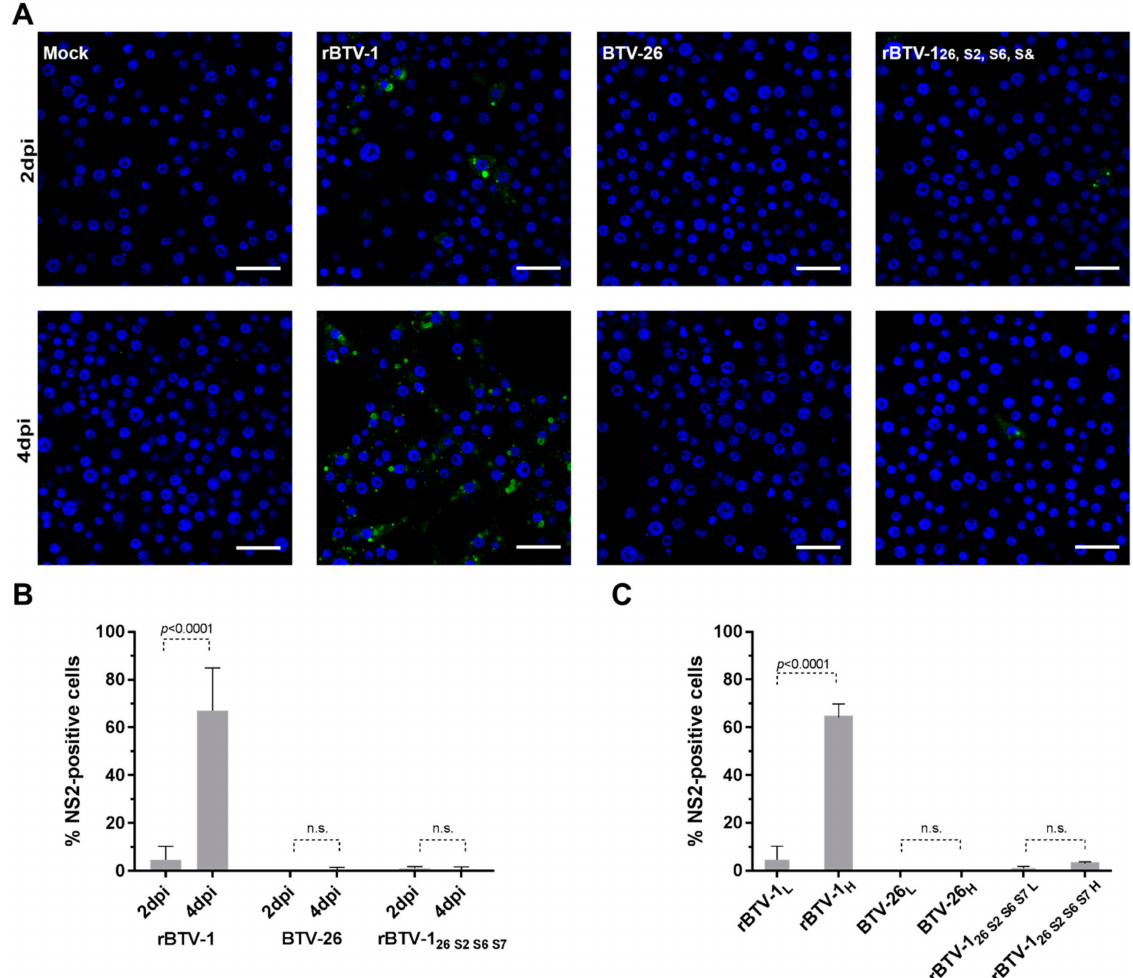
Figure 5. Intracellular replication of rBTV-1, BTV-26 and rBTV-1 26 S2,S6,S7 in Culicoides cells. KC cells were seeded at a density of 7.00E+05 cells/well on coverslips in a 24-well plate at a low MOI of 0.01 ( A , B ). At 2 or 4 days pi cells were fixed with 4% PFA and labelled for DNA (DAPI, in blue) and viral NS2 (Orab1-Alexa Fluor 488, in green). Cells were visualized by confocal laser scanning microscopy ( A ) and the percentage of NS2 positive cells from two independent experiments calculated (over 3000 cells counted) ( B ). In ( A ), the scale bar represents 10 µ m for all panels. In ( C ), a comparison of the percentage of NS2 positive cells at 2 dpi between KC cells infected at low (L) MOI (0.01) or high (H) MOIs (1–5) is shown. Means were compared by carrying out ANOVA tests: a Sidak’s multiple comparison test ( B ) or a Tukey’s multiple comparison test ( C